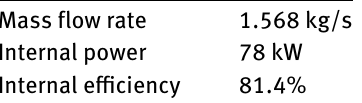
Table 5: The most important results obtained from